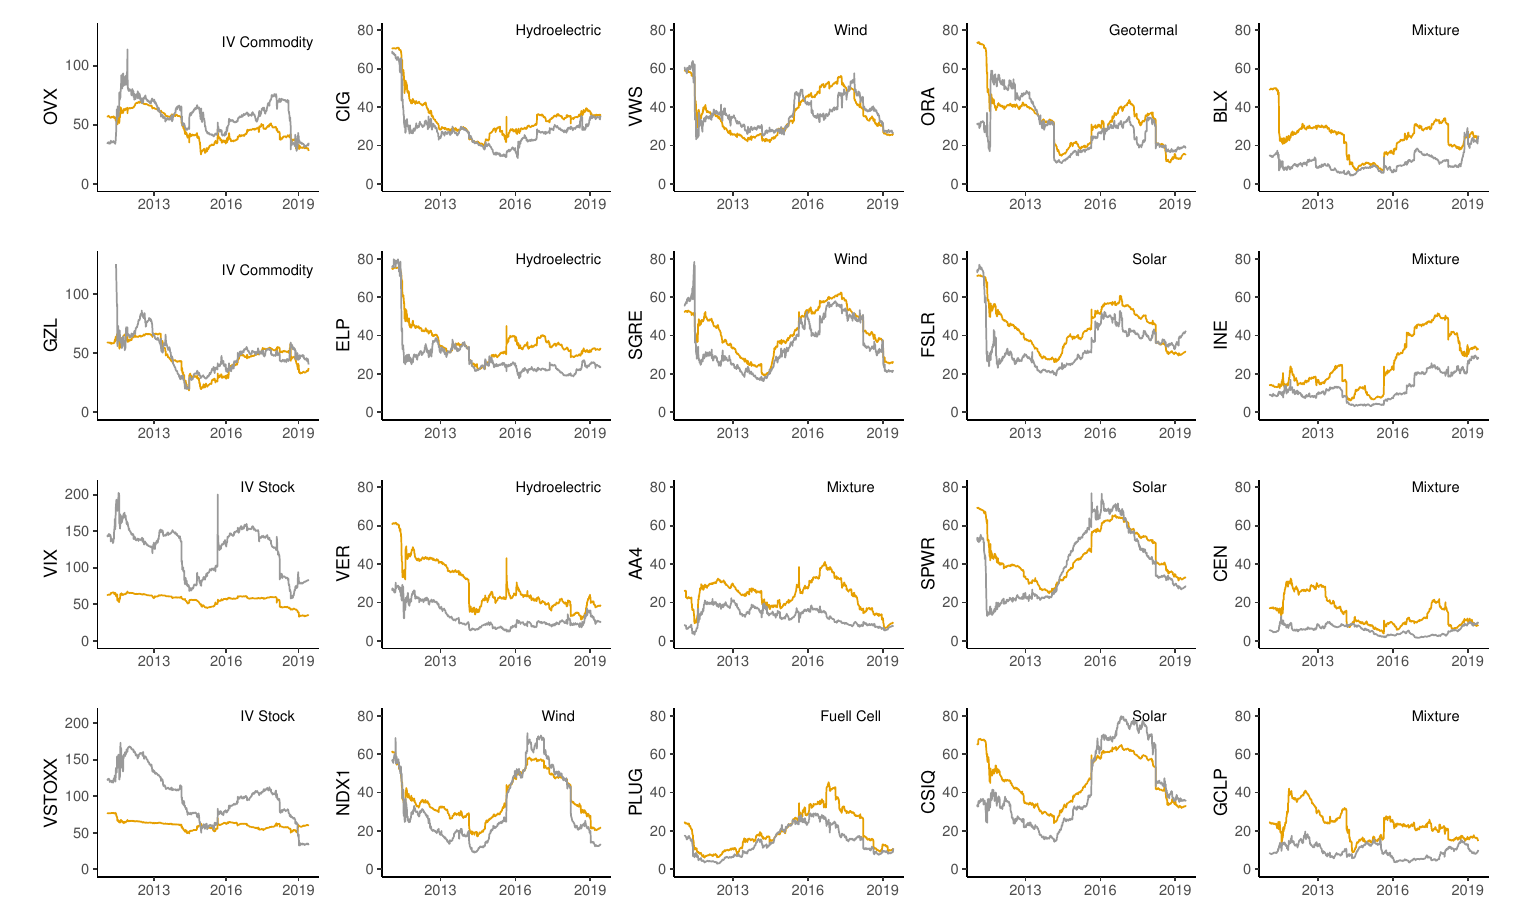
Figure 3. Total directional connectedness C H •← transmitted (“to”, gray line) from the market j to the rest of the system and total directional connectedness C H j received (“from”, orange line) by market i from the rest of the system for the period June 2008 to June 2019. A two-year rolling estimation window is utilized and a 10-step-ahead predictive horizon is used for the underlying variance